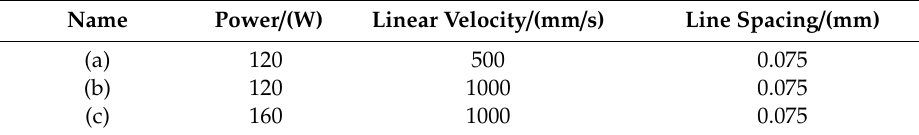
Figure 10. The analysis experiment of the oxidized substrates. ( a ) Image of an oxidized workpiece; ( b ) image of a workpiece with better cleaning performance; ( c ) image of a workpiece with serious oxidation damage. Table 6. The corresponding laser process parameters of Figure 10.